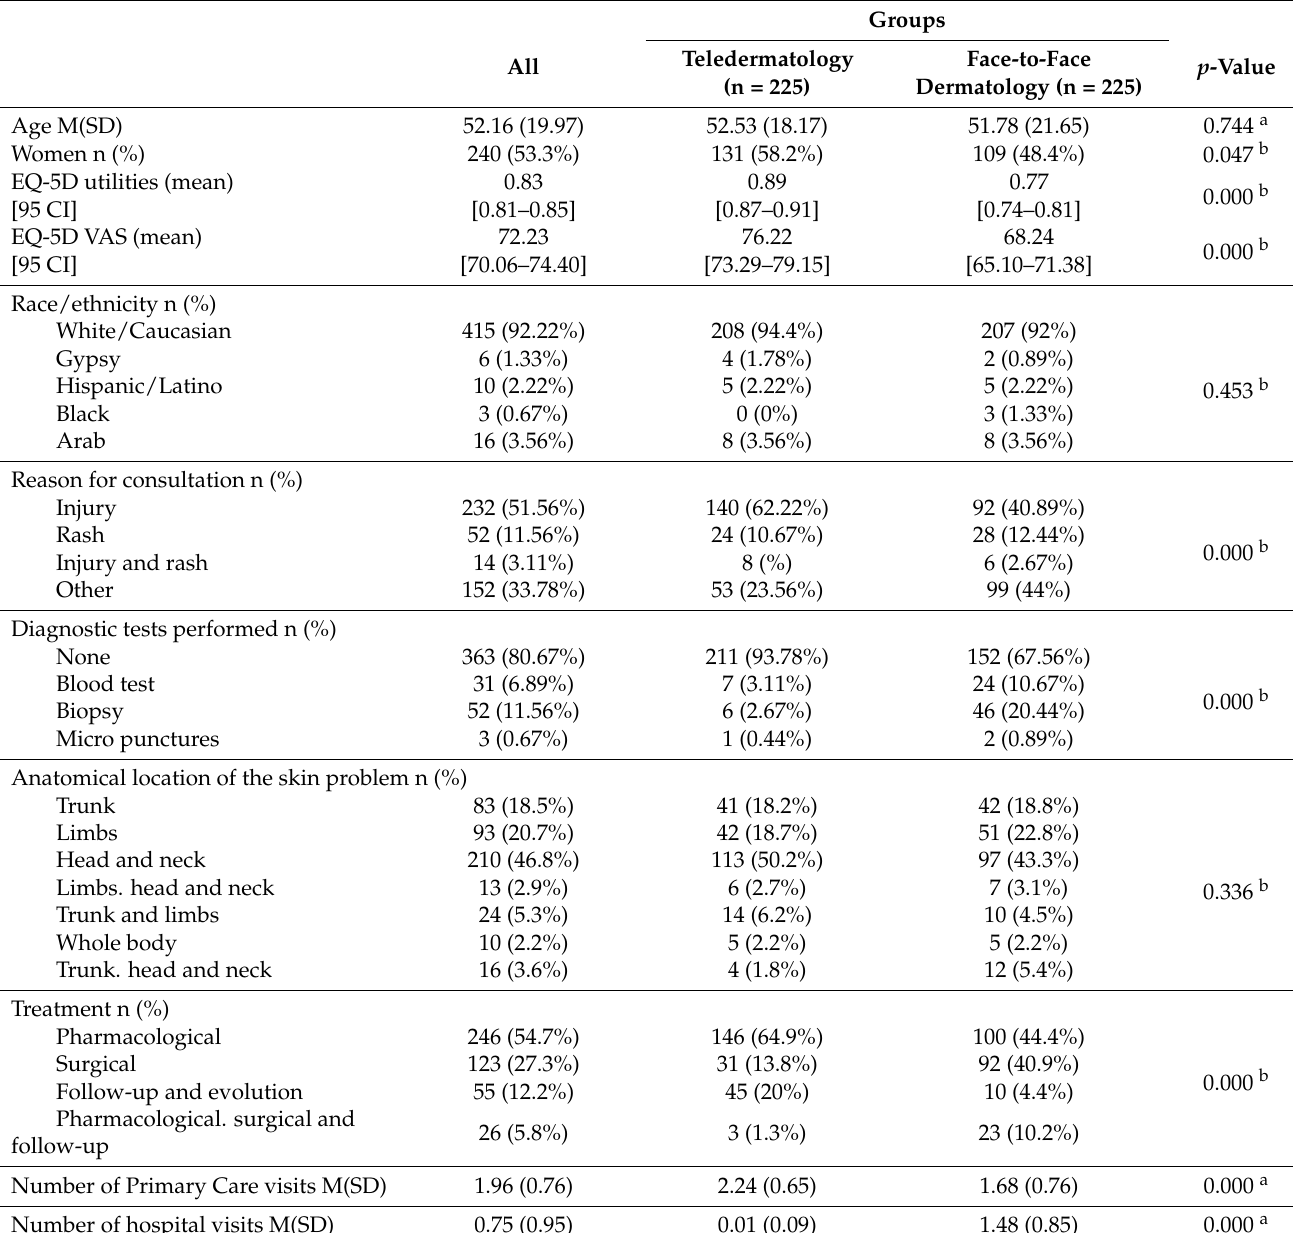
Table 1. Selected patient baseline